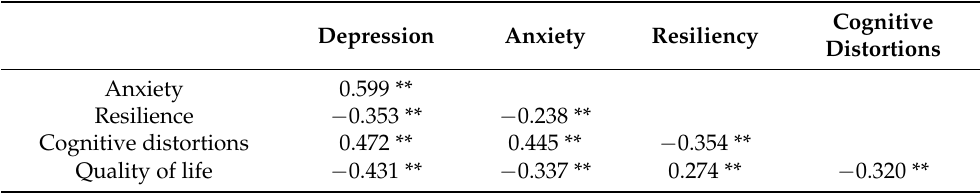
Table 3. Spearman correlation analysis between psychological variables. The correlation coefficients were calculated from the total score of each variable.